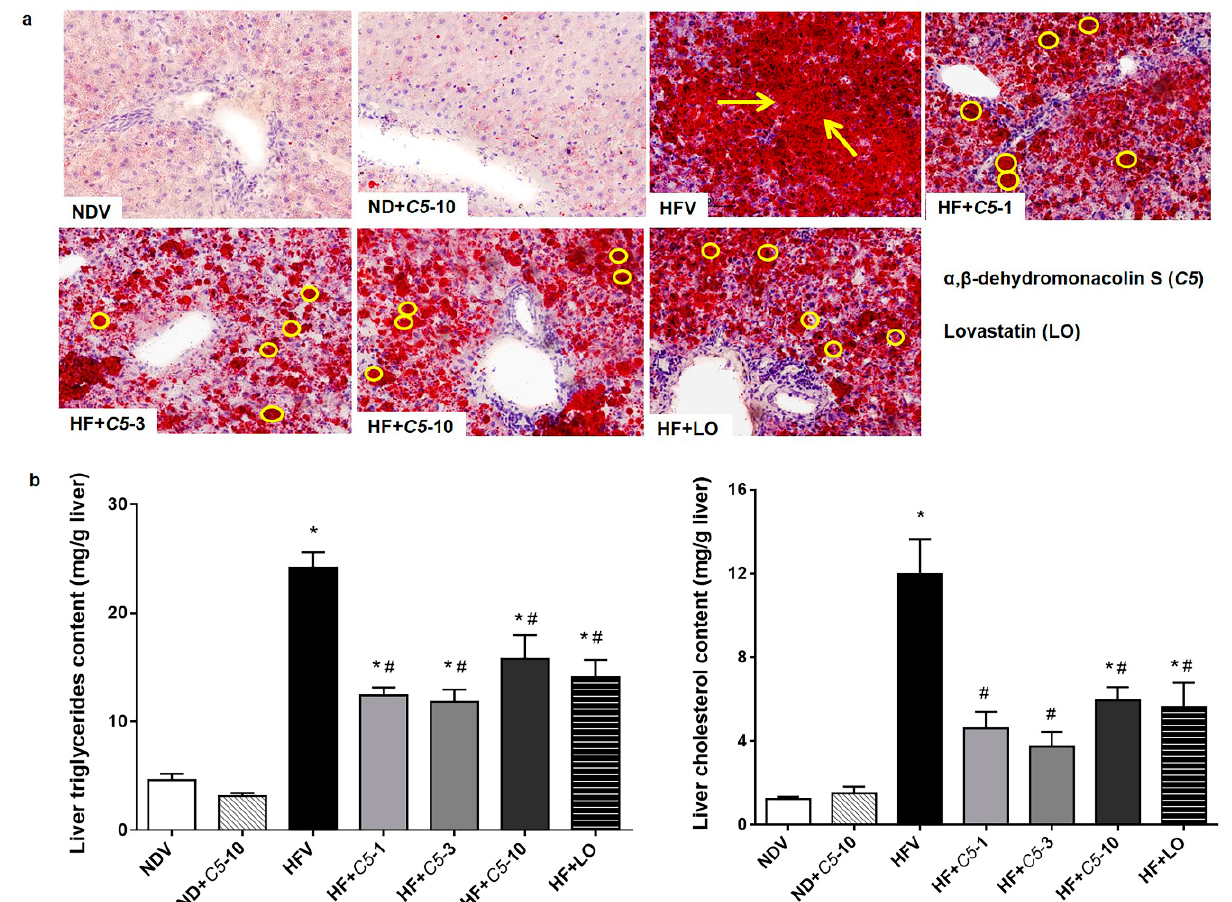
Figure 3. Effect of α , β -dehydromonacolin S ( C5 ) on hepatic lipid accumulation. ( a ) Oil-red-o stained liver sections from each experimental group were analyzed using bright-field microscopy (original magnification 100 × ). The data were repeated at least 3 times from separate sets of animals. The arrow and circle in the panels indicates fat droplet accumulation in liver tissues. ( b ) Triglyceride (TG) and total cholesterol (TC) extracted from liver tissues were quantitated using enzymatic colorimetric assay. Values are mean ± S.E.M ( n = 6), * p < 0.05 represents the significant difference compared with the NDV group and # p < 0.05 represents the significant difference compared with the HFV group.